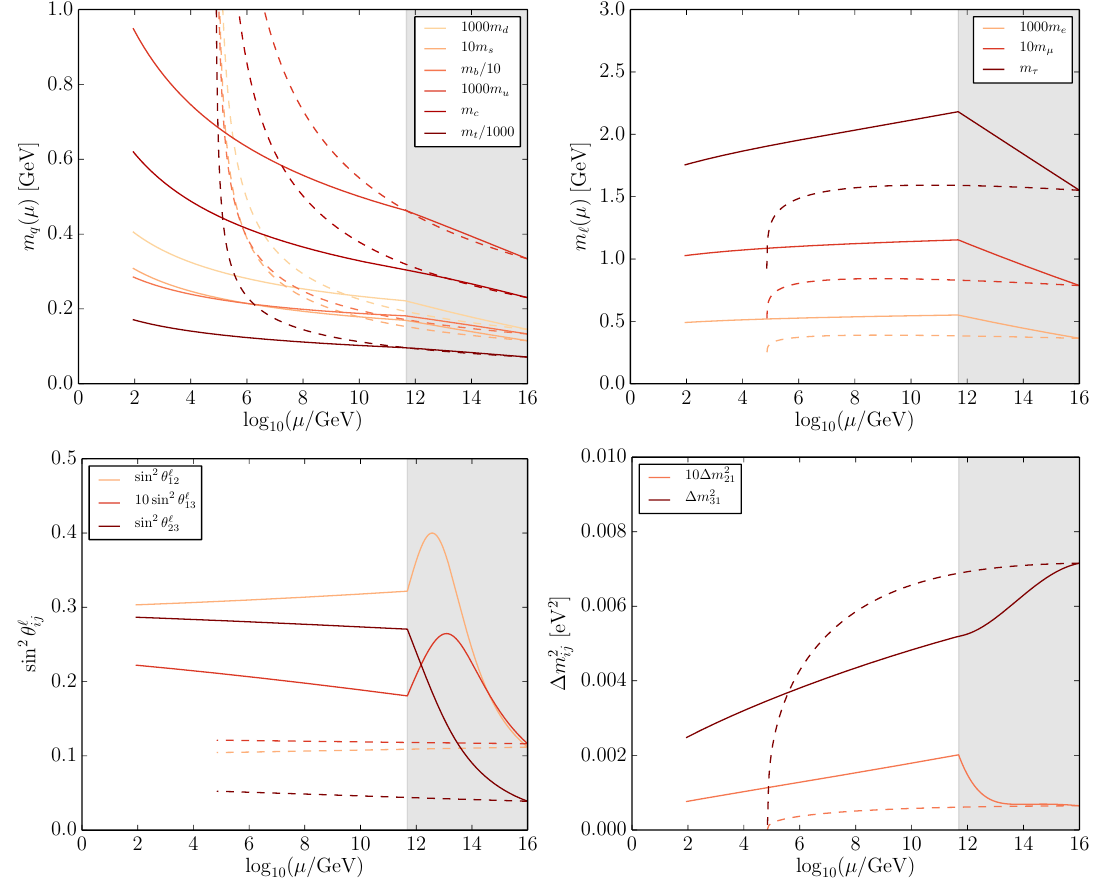
Figure 3 . RG running of the quark masses (upper left panel), charged-lepton masses (upper right panel), leptonic mixing angles (lower left panel), and neutrino mass-squared di(cid:11)erences (lower right panel) in the extended model with normal neutrino mass ordering. The solid (dashed) curve shows the RG running with (without) the intermediate gauge group between M GUT and M I , denoted by the shaded